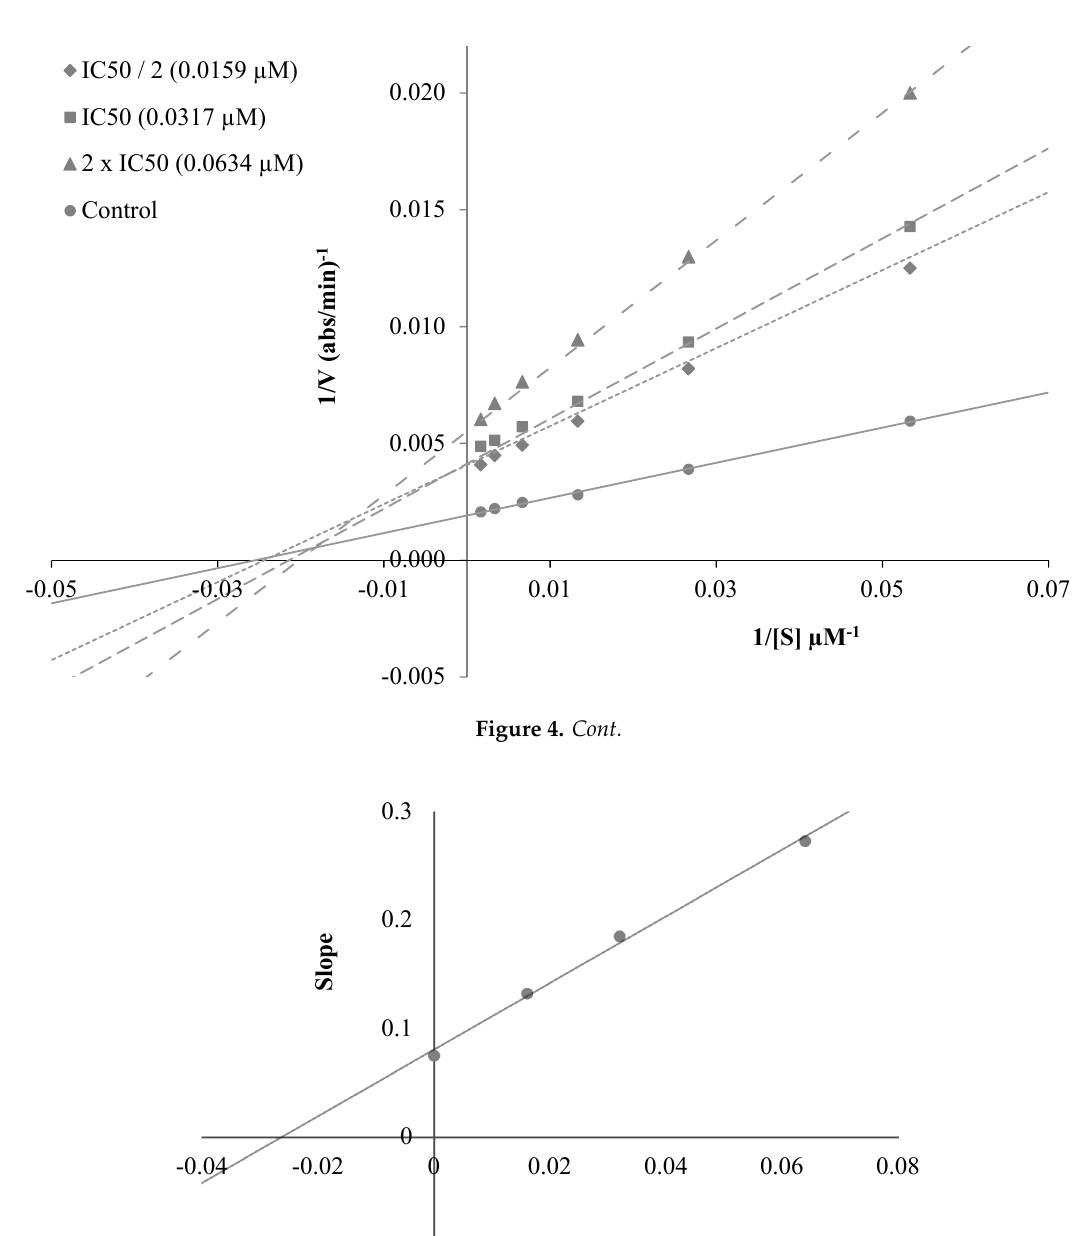
Figure 4. ( A ) Lineweaver–Burk plots for the inhibition of AChE by compound 3c . [S], substrate concentration (µM); V, reaction velocity (abs/min) − 1 . ( B ) Secondary plot for the calculation of steady- state inhibition constant (K i ) of compound 3c . Ki was calculated as 0.0197 µM.